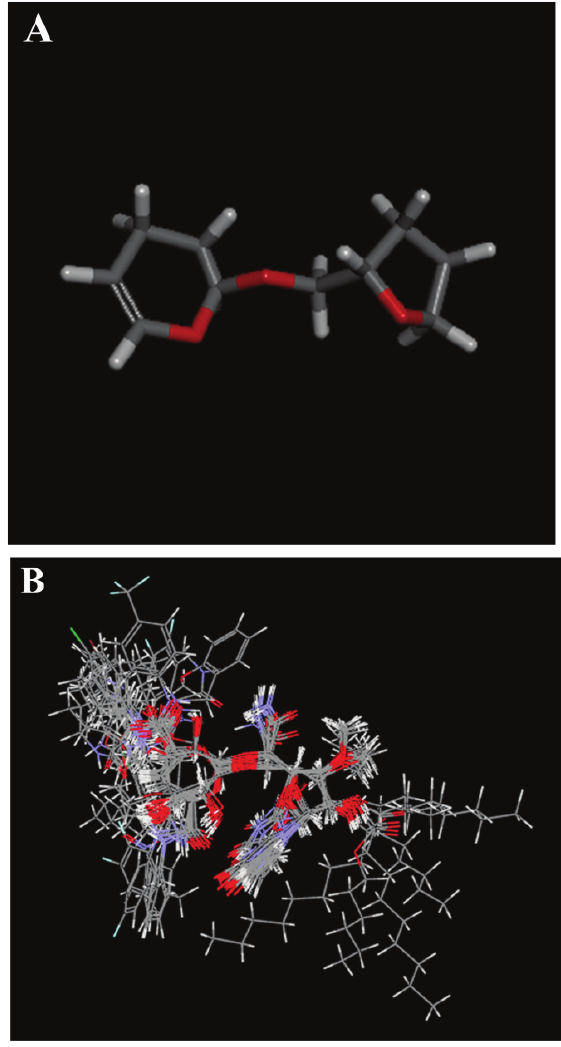
Figure 2: (A) Common scaffold used for alignment. (B) Structural alignment of the training set